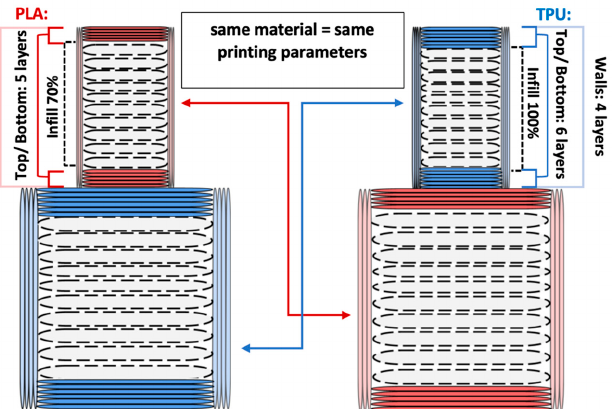
Figure 4. Graphical representation of sample configurations. Each part is divided into three zones: walls, top/bottom layers, and intermediate infill for both materials: thermoplastic polyurethane (blue) and polylactic acid (red).